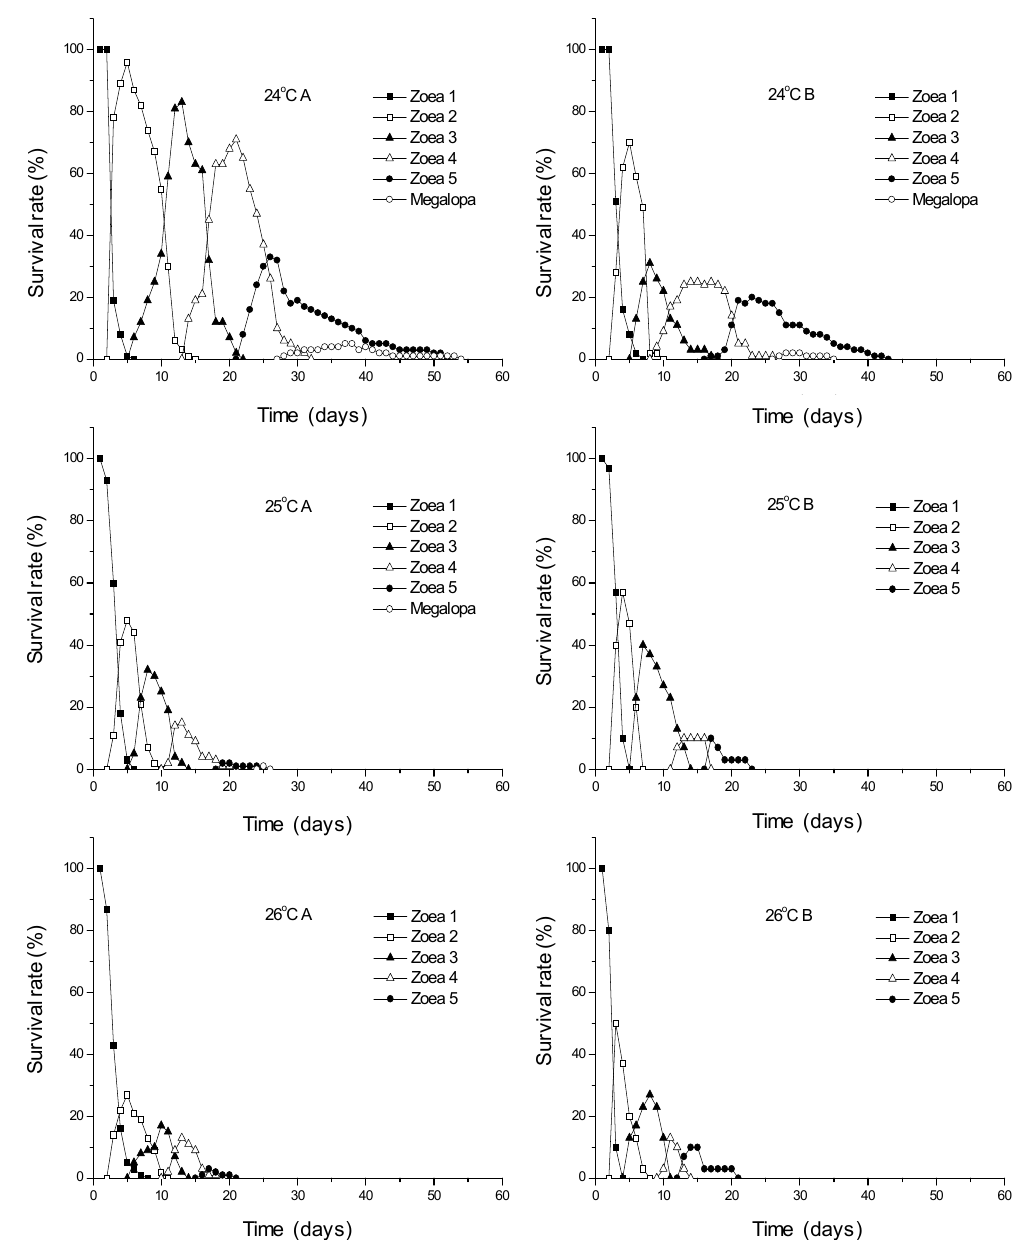
Figure 3. Survival rate ( % ) for each developmental stage from hatching of D. japonicus reared at 24, 25, and 26 °C.